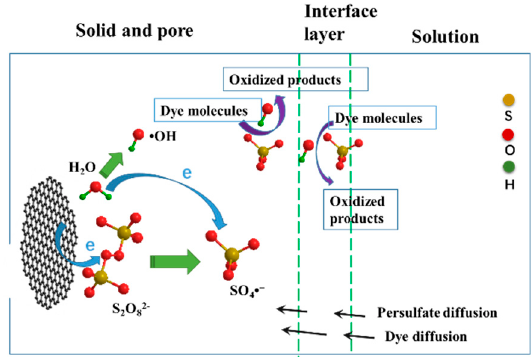
Figure 6. Simplified reaction pathways for AR97 degradation by EG/PDS system.